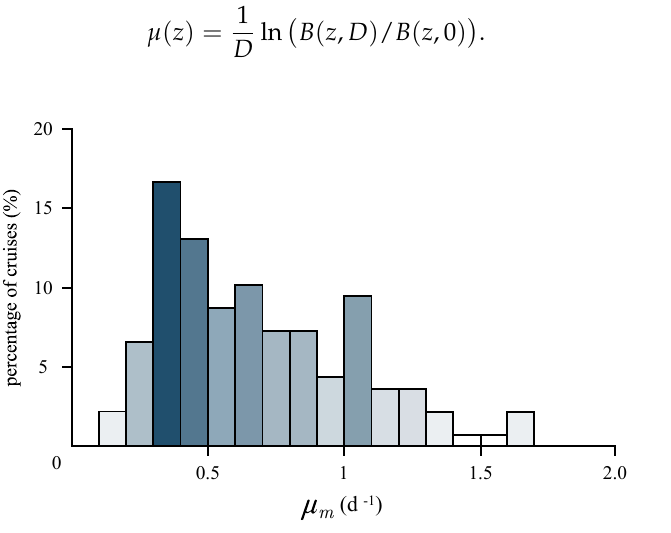
Figure 5. Histogram of the estimated maximum daily growth rate, µ m , obtained from 138 cruises based on Equation (12) and here multiplied by the daylength, D , to convert hourly into daily rates. The value of the carbon-to-chlorophyll ratio χ is 146 mgC ( mgChl ) − 1 , taken from Maranon